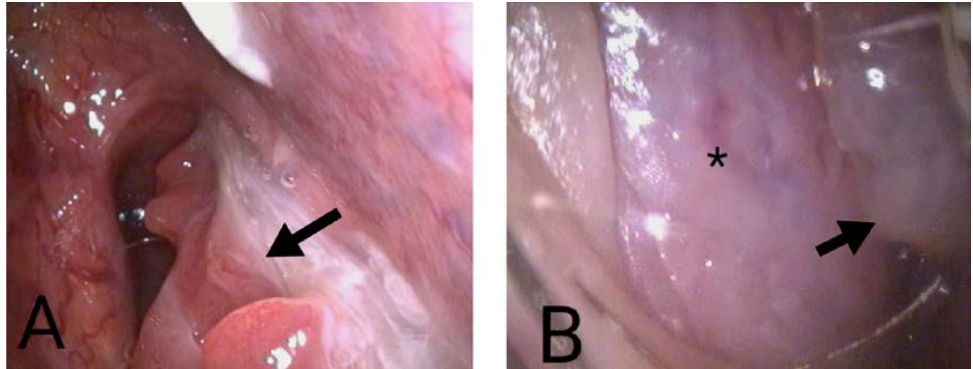
Figure 1. Endoscopic view of the nasal tumor ( A ) right choanal extension of the tumor (black arrow) ( B ) tumor occupying the entire left nasal fossa (black arrow), anterior nasal deviation (*). A computed tomographic scanning of the head and paranasal sinuses was performed, showing extensive parafluid-solid densities completely occupying the left maxillar, eth- moidal, sphenoidal sinuses and the entire left nasal cavity, expanding in the nasopharynx through the left choana. (Figure